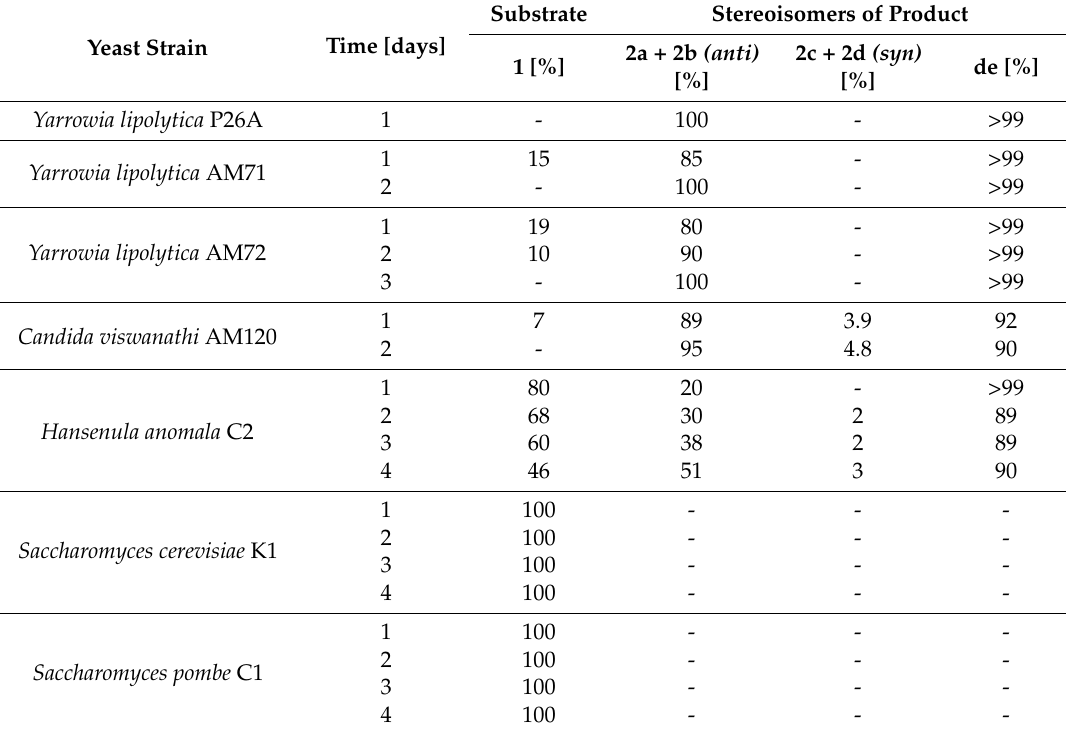
Table 1. The results of screening biotransformation of α -acetylbutyrolactone 1 (in % according to GC).